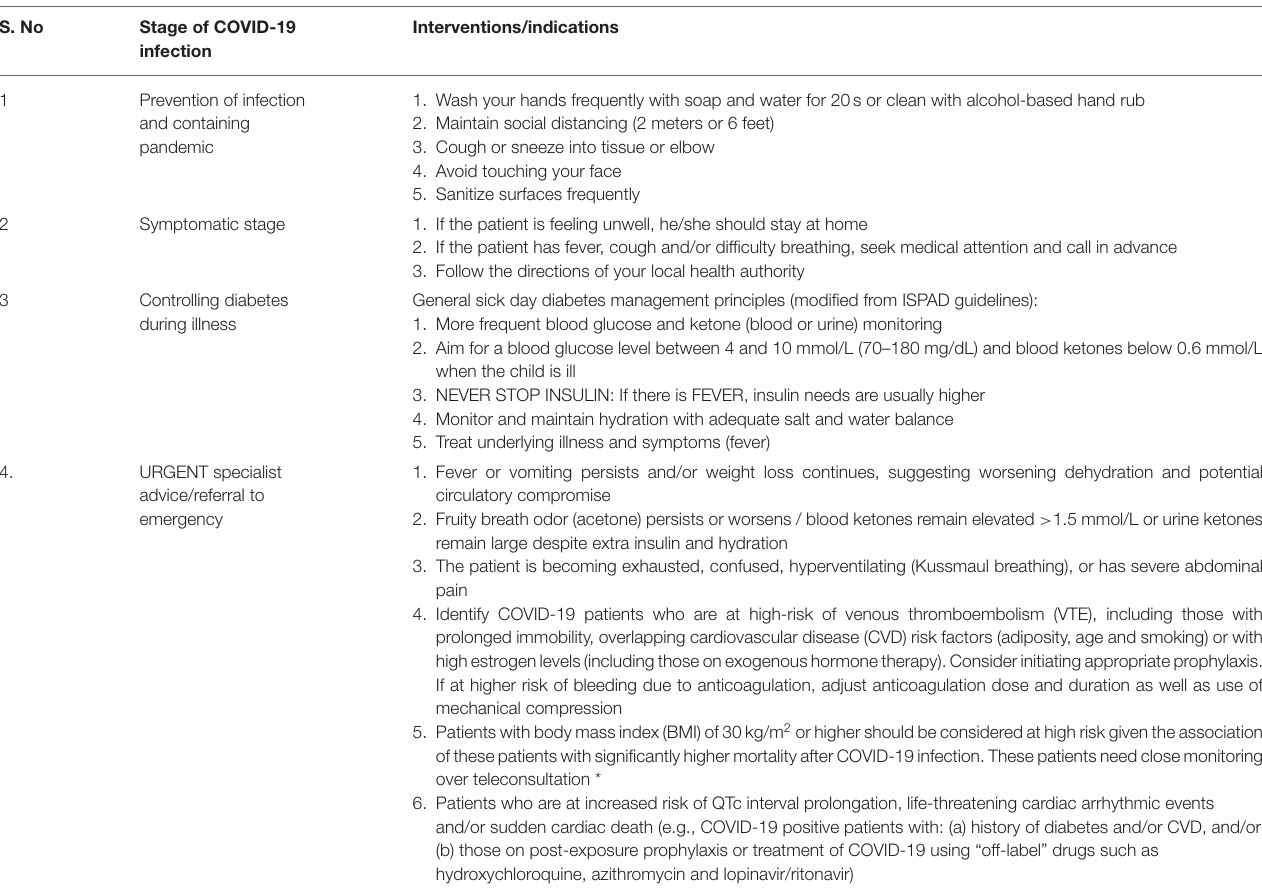
TABLE 1 | Summary of recommendations regarding COVID-19 in patients with diabetes and/or cardiovascular disease. S.